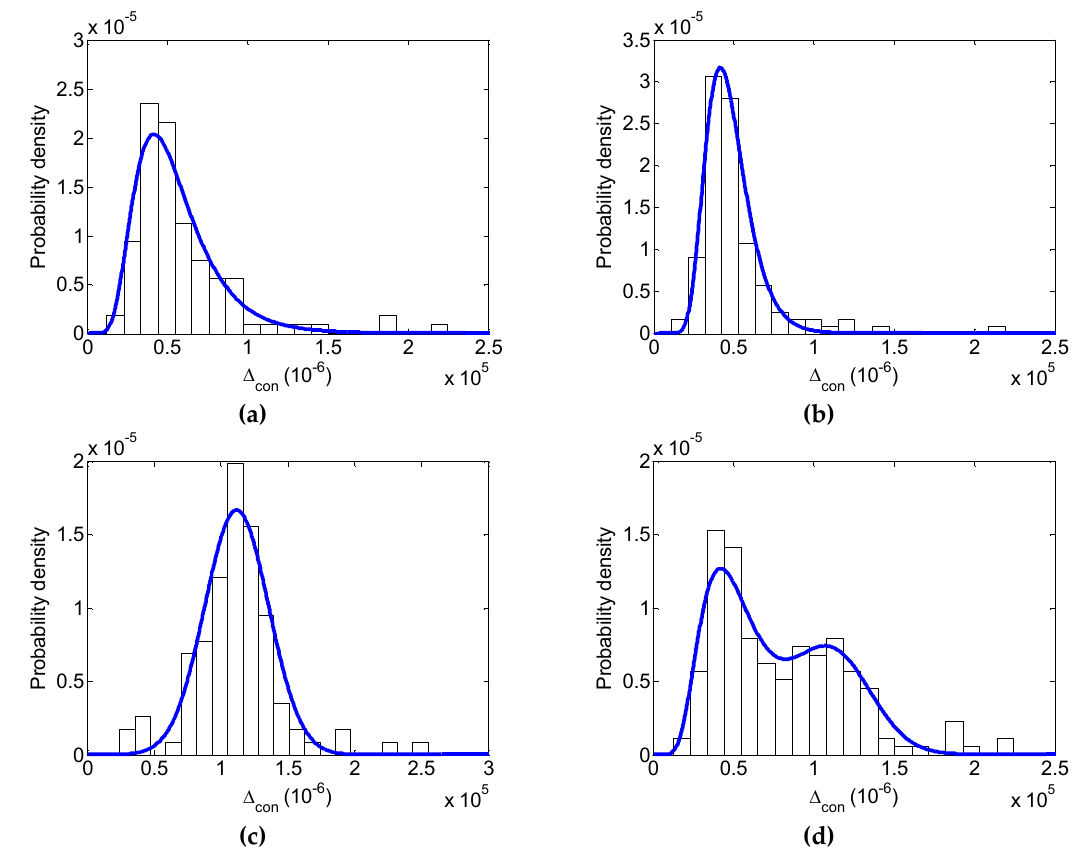
Figure 7. Reconstruction of the constrained SFS for concrete: histograms and theoretical probability density curves for ( a ) HCP, ( b ) ITZ, ( c ) aggregate, and ( d ) concrete reconstructed with Equation (30).